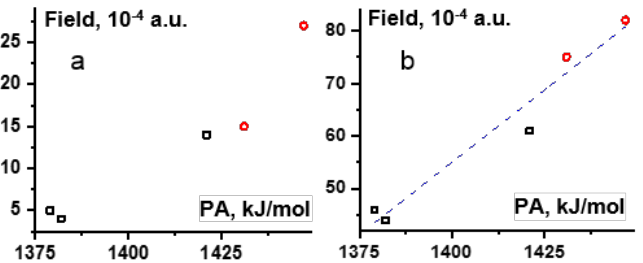
Figure 6. The lower limit of the external electric field simulated the effect of CDF 3 /CDClF 2 on 2 , 3 , 5 (black □) and 4 , 6 (red ○ ) under the PCM ( a ) and gas-phase ( b ) approximations as a function of the PA of the involved acids.